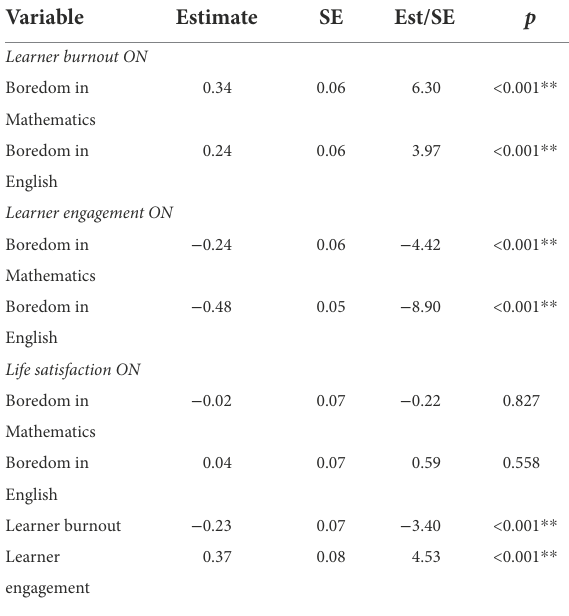
TABLE 5 Standardized regression coefficients with learner burnout, engagement and life satisfaction as dependent